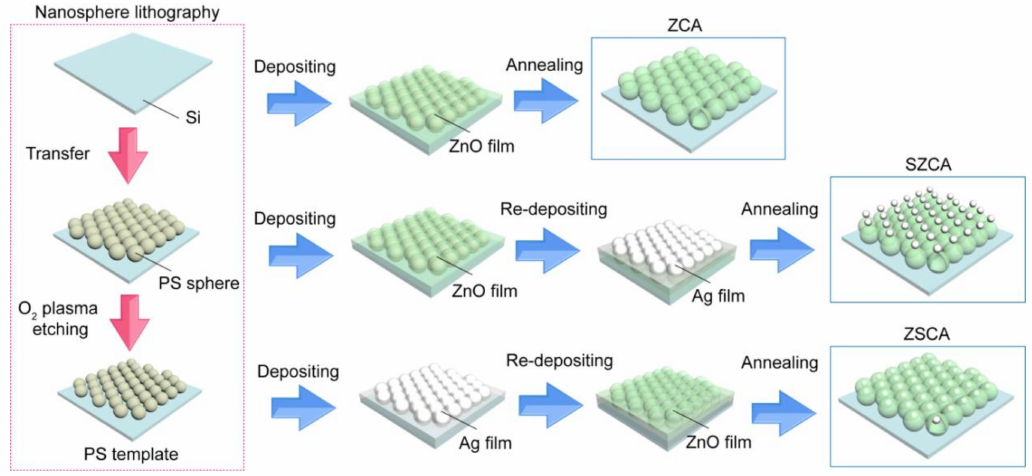
Figure 1. Fabrication procedures of arrays of ZnO nanocavities (ZCA), AgNP (on)-ZnO nanocavities (SZCA), and AgNP (in)-ZnO nanocavities